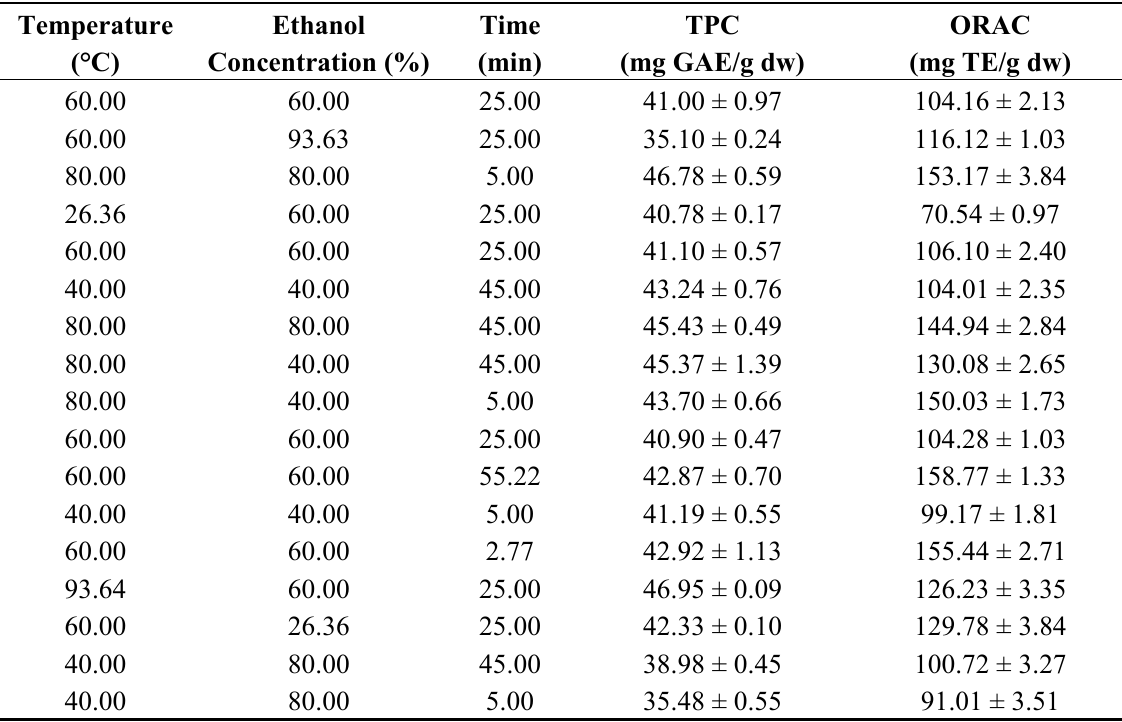
Table 1. Experimental design and responses for